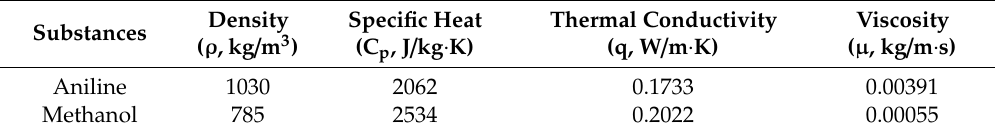
Table 2. Properties of substances (298 K, 1 atm).